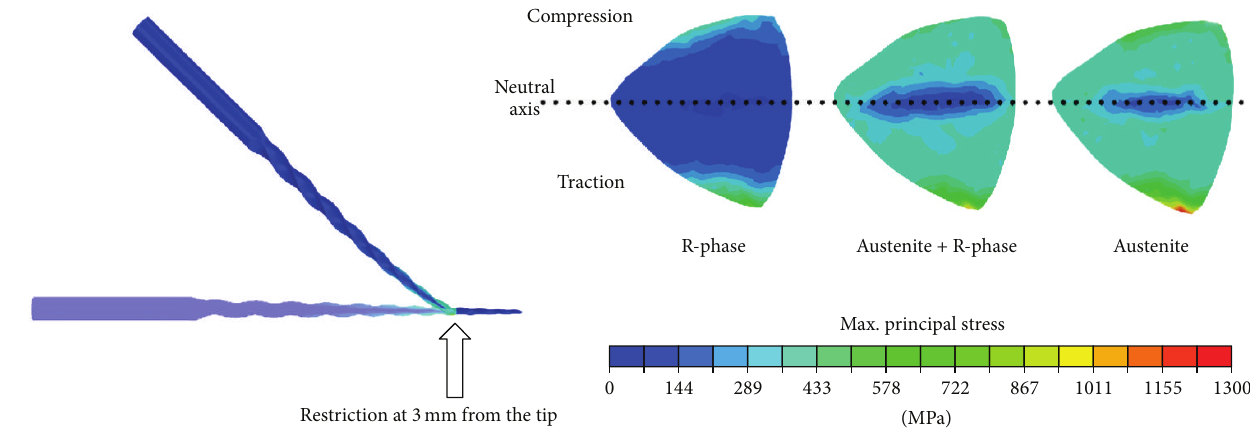
Figure 10: Maximum principal stress distributions in the endodontic instruments subjected to bending.